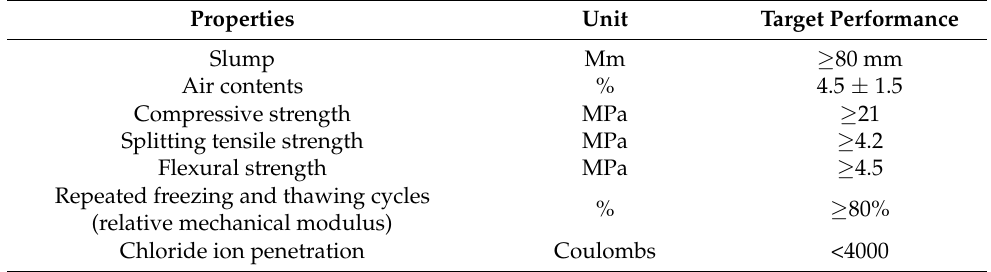
Table 7. Target performance of the rural-road pavement using air-cooled slag aggregate [1,21,22].